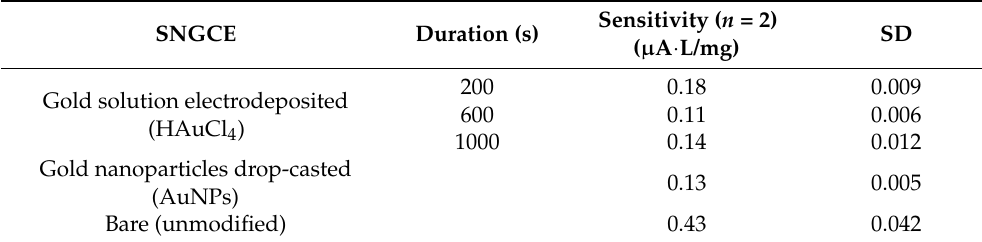
Table 2. Sensitivity of modified and unmodified